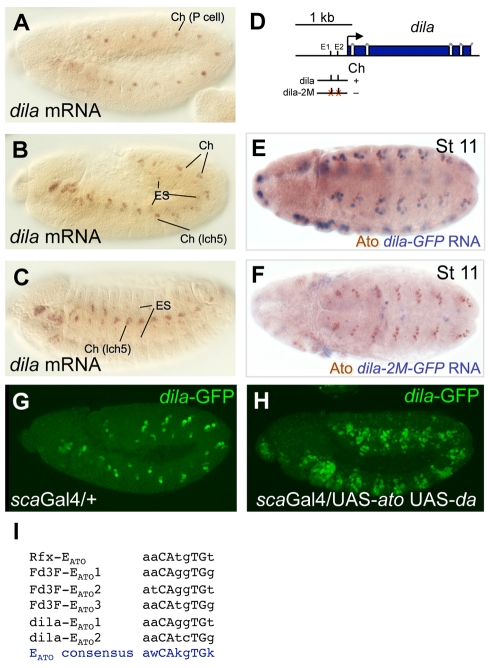

dila is a direct target of ato in the pathway to differentiation.(A–C) Expression of dila mRNA at stages 11, 12, and 15. dila is a Ch-enriched gene, being expressed strongly in Ch cells and weakly in ES cells. (D) Schematic of the first four exons of the dila gene, showing the location of the enhancer fragments tested, and the two E boxes within it. (E) dila-GFP in stage 11 embryo. GFP is driven by dila enhancer in early Ch cells, which express ato. (F) dila-2M-GFP. Mutation of two EATO boxes in the dila enhancer abolishes early Ch cell expression. (G,H) dila-GFP responds to ato misexpression. (G) Expression of dila-GFP in scaGal4 driver background (wild type). (H) Ectopic expression of dila-GFP in embryo in which ato and its partner, da, are jointly misexpressed in the ectoderm. (I) Summary of E box motifs in potential ato target enhancers relative to the ato-specific consensus, EATO
[7]. Note that dila-EATO2 does not completely match the consensus and appears to bind ATO/DA more weakly in vitro (Figure S5).